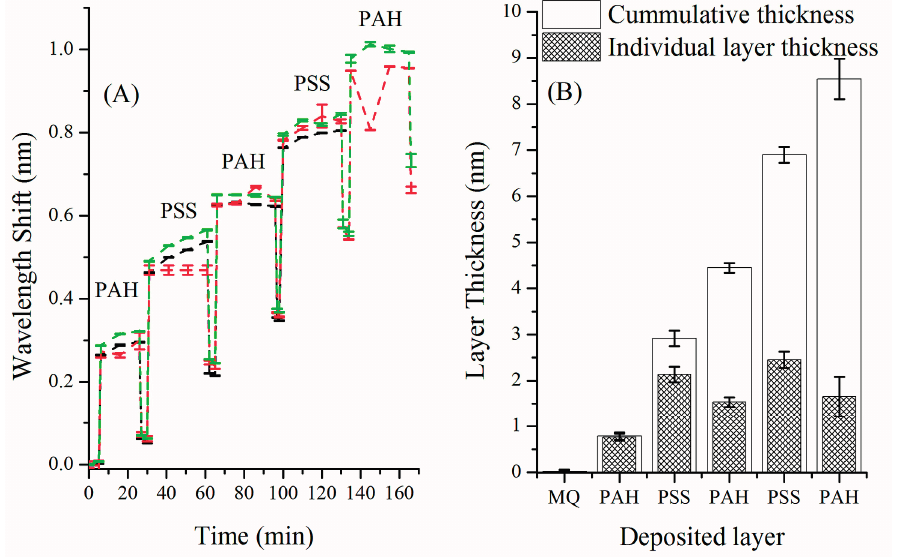
Figure 3. ( A ) Wavelength shift of the WGM of a Ø = 20 µm polystyrene dye doped microsphere for increasing number of deposited polyelectrolyte layers; ( B ) Cumulative and individual layer thickness calculated after the deposition of each polyelectrolyte